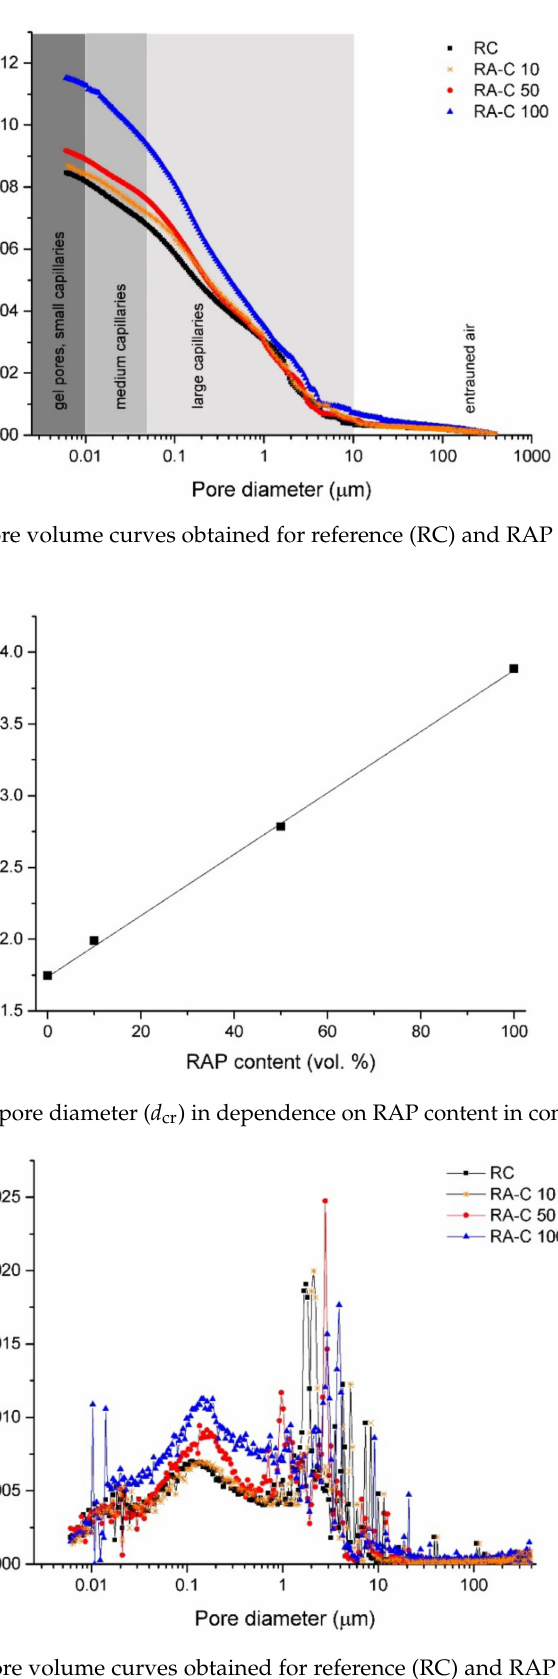
Figure 9. Incremental pore volume curves obtained for reference (RC) and RAP modifies (RA-C 10, RA-C 50, RA-C 100)